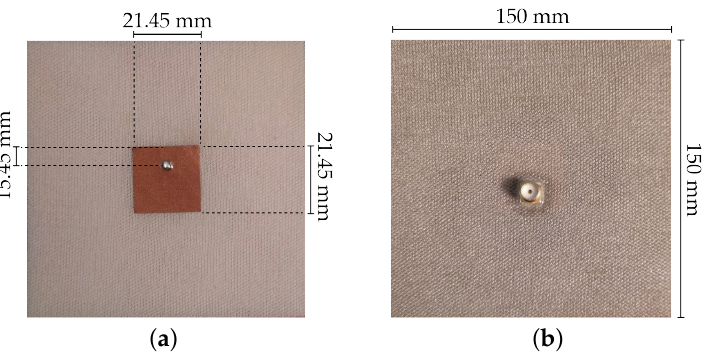
Figure 6. Textile microstrip patch antenna used to characterize the dielectric properties of SIGP: ( a ) front and ( b )